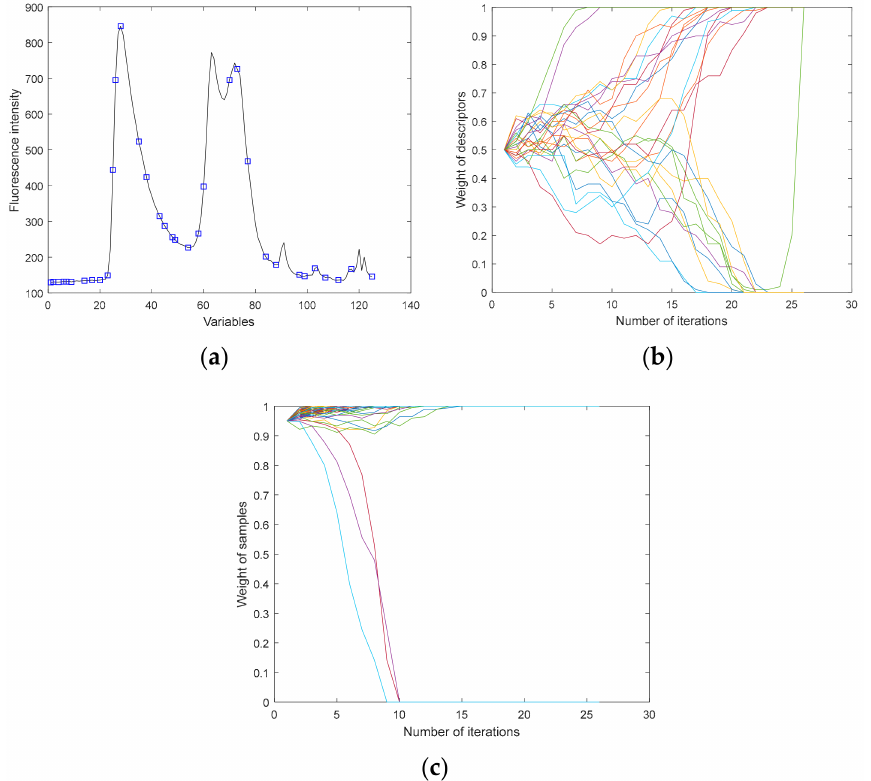
Figure 8. The extraction process of MASS: ( a ) distribution of effective variables; ( b ) the change process of the weights of variables; ( c ) the change process of the weights of